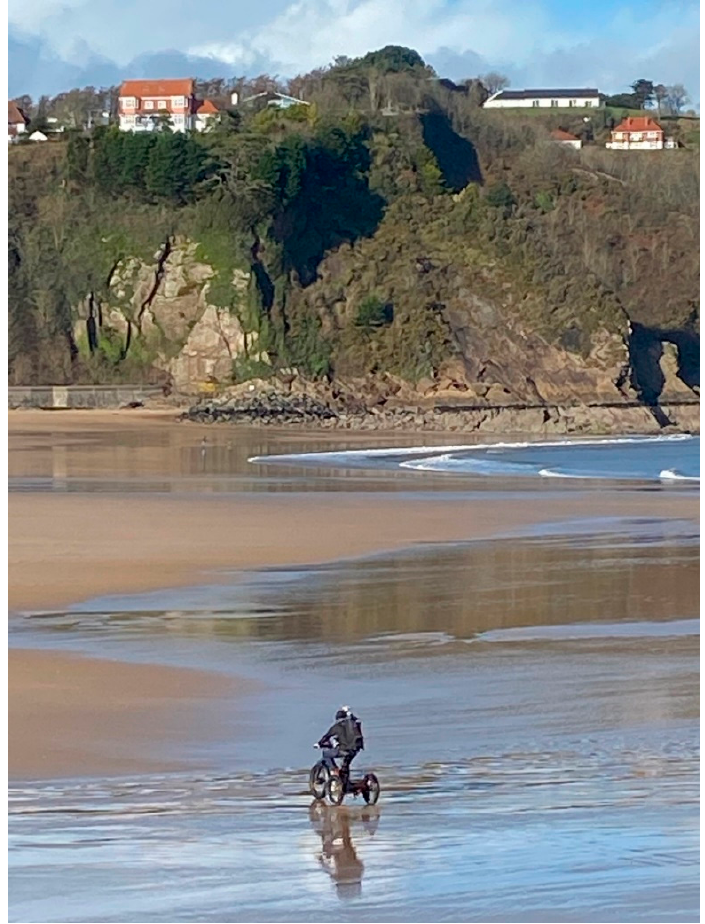
Figure 4. Inside the Long Gallery of Nottingham Castle.